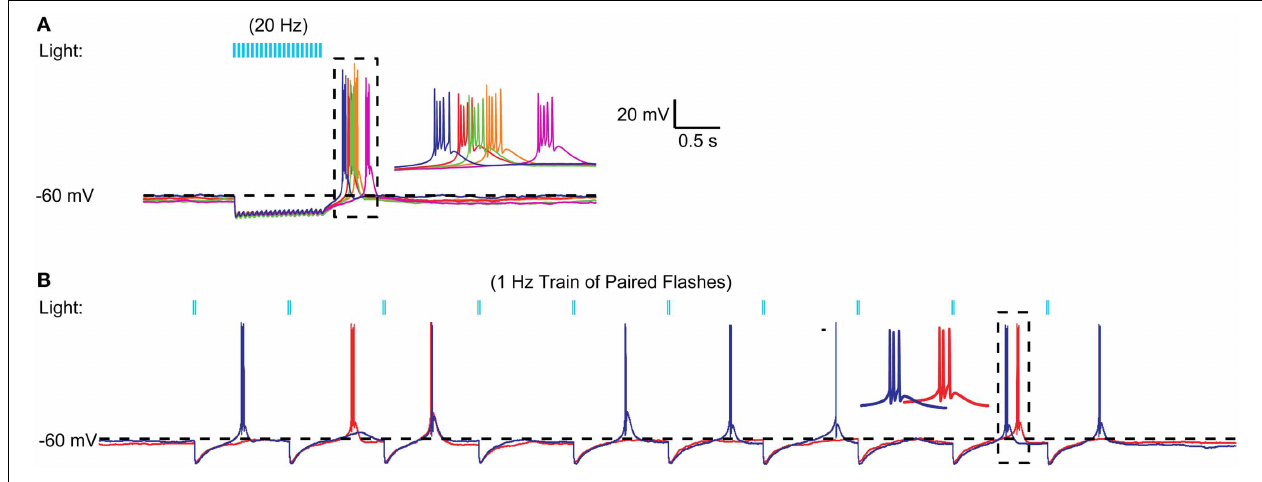
FIGURE 5 | Example of high frequency optical stimulation trains and brief stimulation bursts to elicit LTS bursts. (A) A 1s 20Hz train of IPSPs triggered by 5ms light pulses resulted in an LTS rebound burst at varying latencies. A 20-Hz train of 50 IPSPs triggered by 5ms light pulses